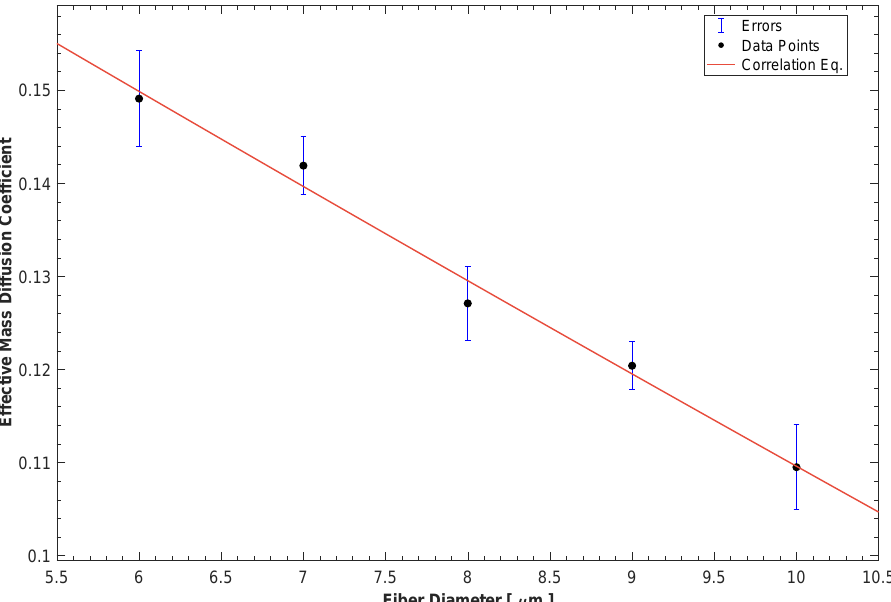
Figure 6. Computed mass diffusion of the GDLs as a function of the fiber diameter. The proposed correlation, which is an exponential function, presented a good fit to the